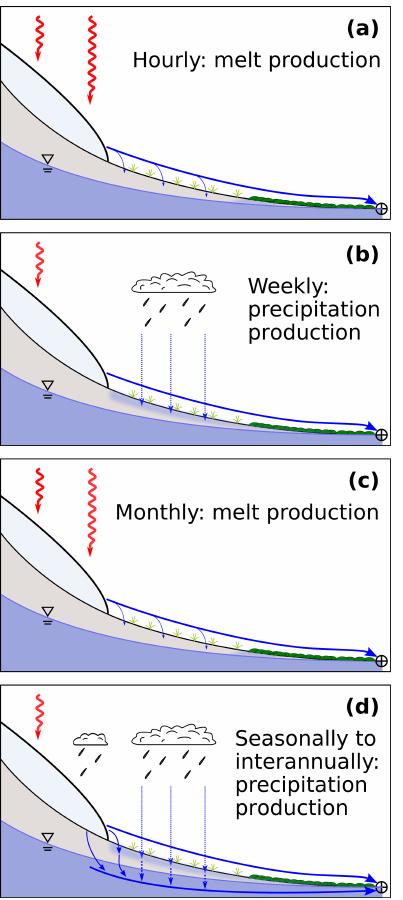
Figure 9. Relative melt contributions drive nearly all the vari- ability in discharge in Gavilan Machay, mostly through surface runoff of glacial meltwater. What drives the variability in rela- tive melt contributions to discharge? Our results show that this depends on the timescale. (a) Hourly timescale variability is con- trolled by radiation-driven (red arrows) melt production (light blue slab at upper left), which readily runs off overland (thick blue ar- row) and eventually reaches the watershed’s discharge point (circle with cross). (b) Weekly timescale variability is controlled by weekly precipitation events, which likely generate antecedent moisture con- ditions (light blue shading) that promote greater meltwater runoff. (c) Monthly timescale variability is driven by monthly trends in melt generation, which contributes to discharge mostly through surface runoff. (d) Seasonal to interannual variability is driven by long-term precipitation, which can enhance melt by transferring heat from rain (blue arrows to the right of the glacier tongue) and augment subsur- face melt contributions through increased groundwater flow (thick blue arrow below water